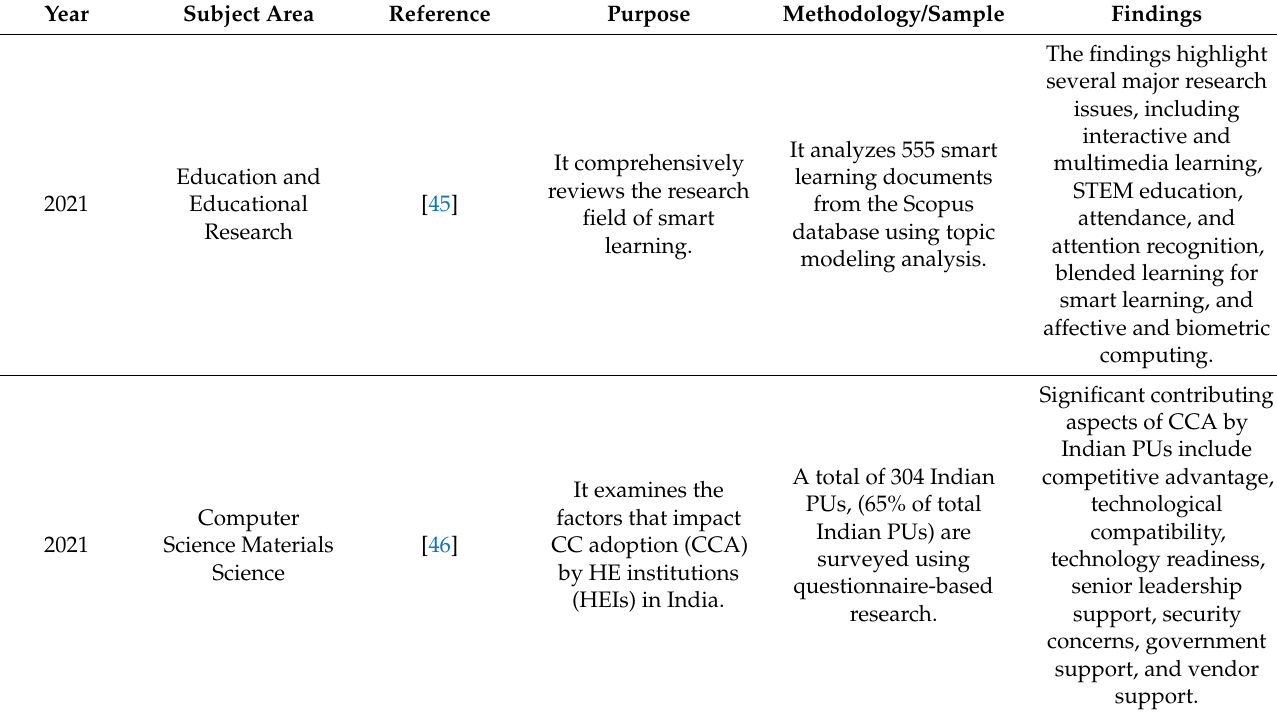
Table 2. Previous literature analysis.